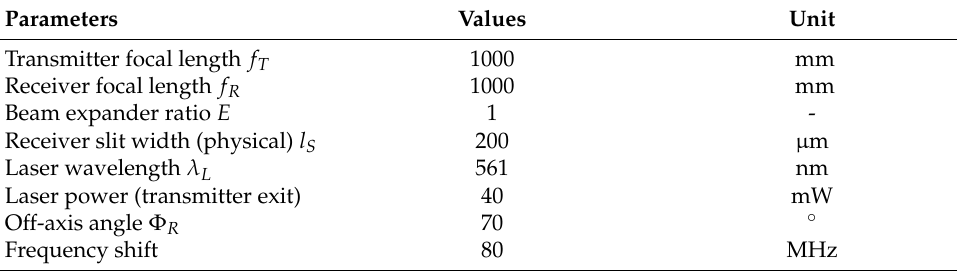
Table 2. Evaluated settings of fiber PDA for application in labscale experiments.